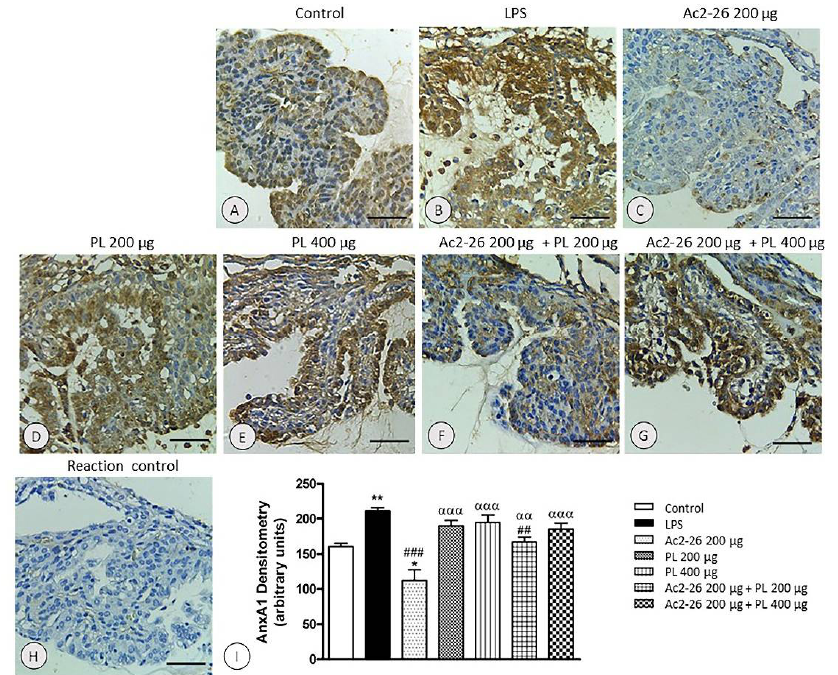
Figure 6. Expression of AnxA1 in ciliary processes in EIU. Increased expression after 24 h of induction of inflammation in the untreated (LPS) ( B ) and treated groups with PL ( D , E ) and Ac2-26 + PL 400 µg ( G ) relative to the control ( A ). Reduction of immunoreactivity after treatments with Ac2-26 ( C ) and Ac2-26 + PL 200 µg ( F ) compared to LPS. Absence of immuno- reactivity in the control of the reaction ( H ). Counterstaining: hematoxylin, bars: 10 µm. Densitometric analysis of AnxA1 ( I ). Results were obtained as mean ± SEM of the densitometric index of the eyes of control rats, untreated uveitis (LPS), and treated groups (Ac2-26 200 µg, PL 200 µg, PL 400 µg, Ac2-26 + PL 200 µg, and Ac2-26+ PL 400 µg) ( n = 10 ani- mals/group). ** p < 0.01 and * p < 0.05 versus control; ## p < 0.01 and ### p < 0.001 versus LPS; ααα p < 0.001 and αα p < 0.01 versus Ac2-262 00 µg.